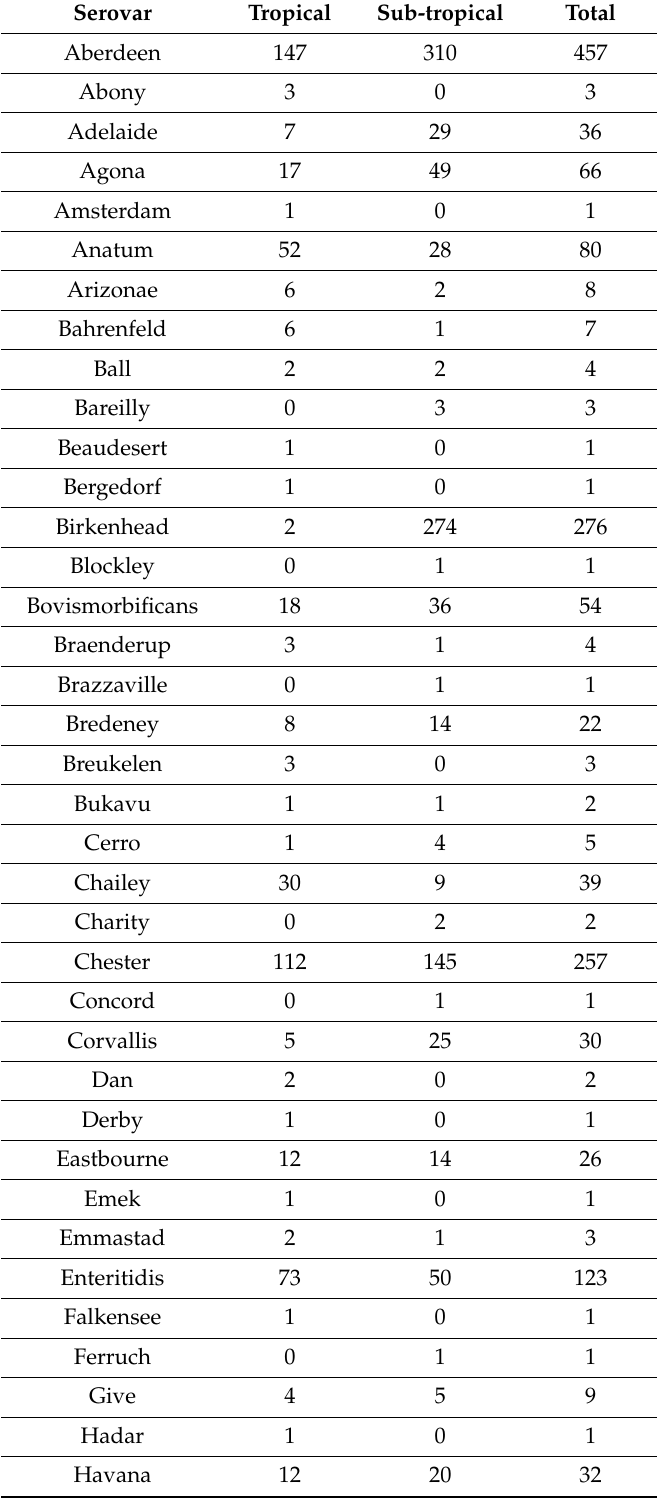
Table A1. Frequencies of Salmonella Serovars in tropical and sub-tropical areas for all positive